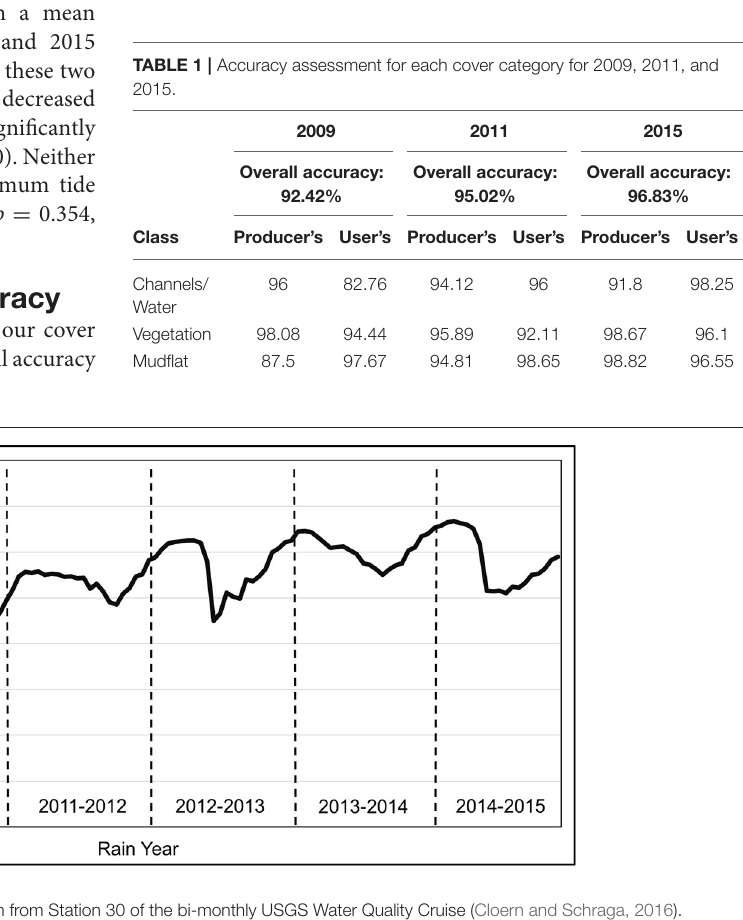
Frontiers in Marine Science |